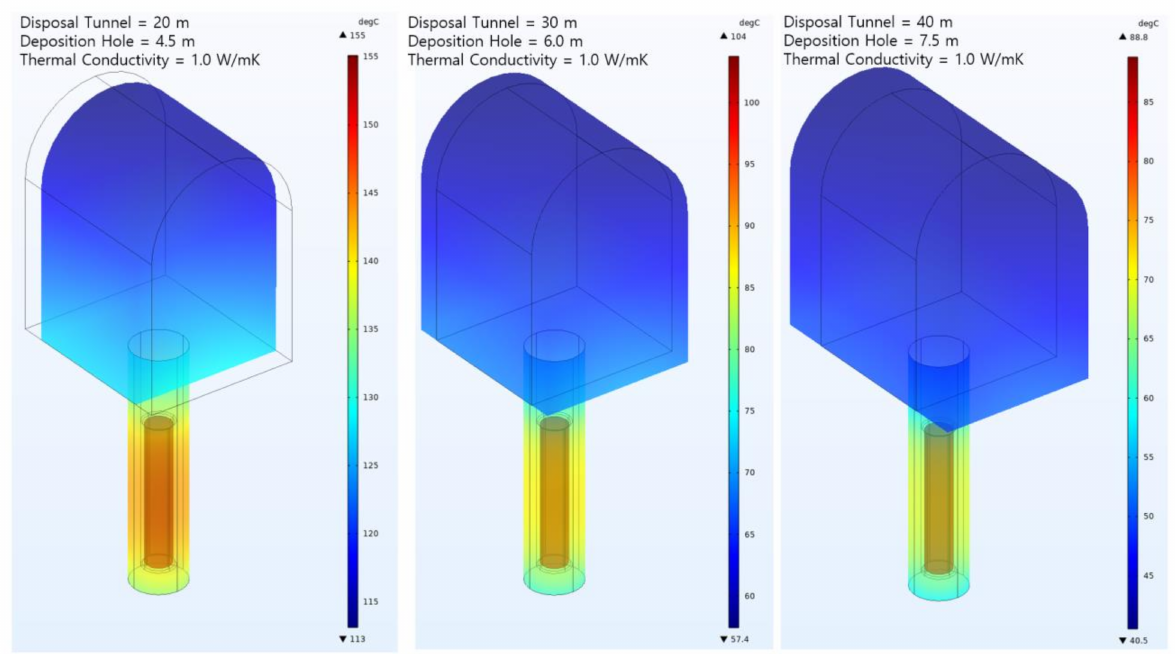
Figure 6. Representative numerical results for temperature distribution of the engineered barrier system according to the